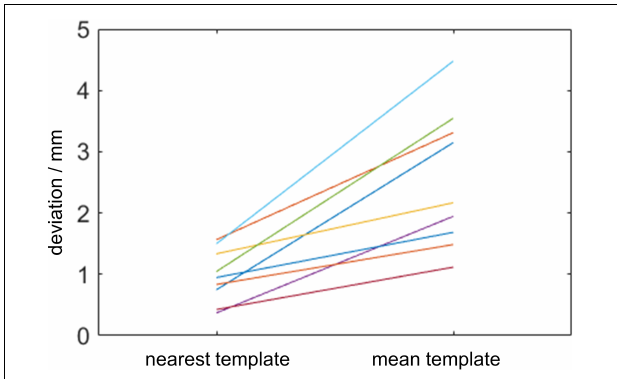
FIGURE 6 | Deviation of the center of proximal contact before and after